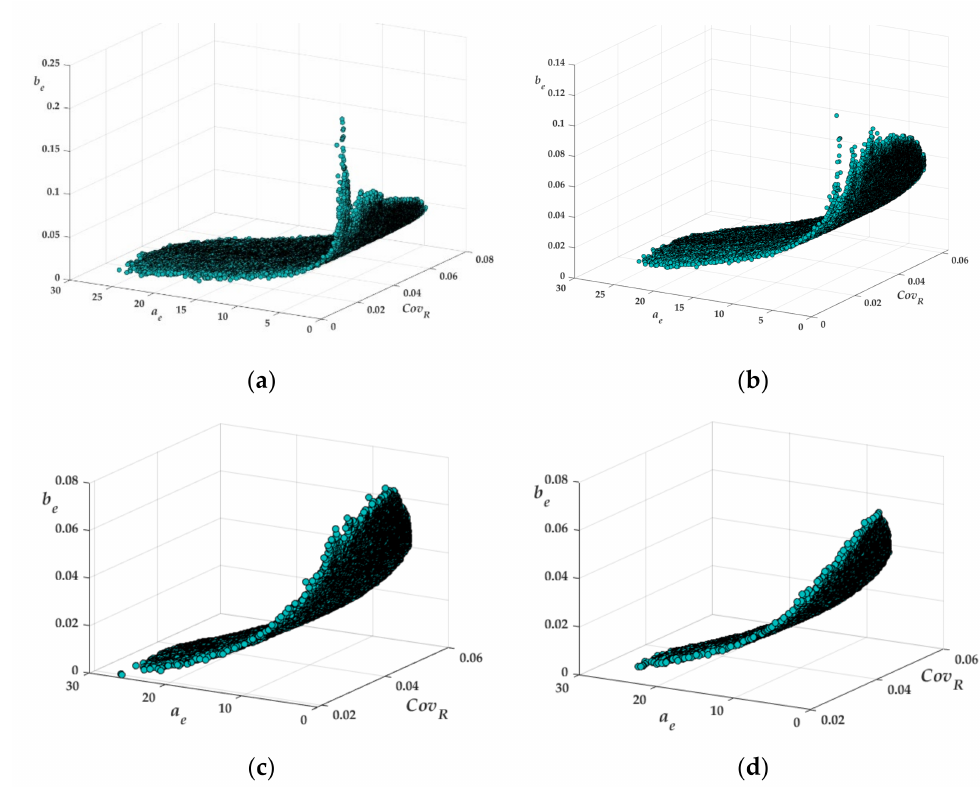
Figure 6. Relationship between the coefficients of the calibrated exponential empirical laws ( a e , b e ) and the coefficient of variation of rebound index Cov R : ( a ) m = 8; ( b ) m = 11; ( c ) m = 15, ( d ) m = 18.